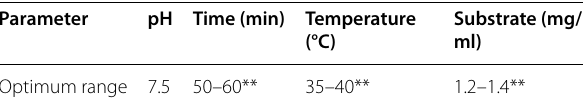
Table 2 Optimum process parameters for the characterization of purified actinidin